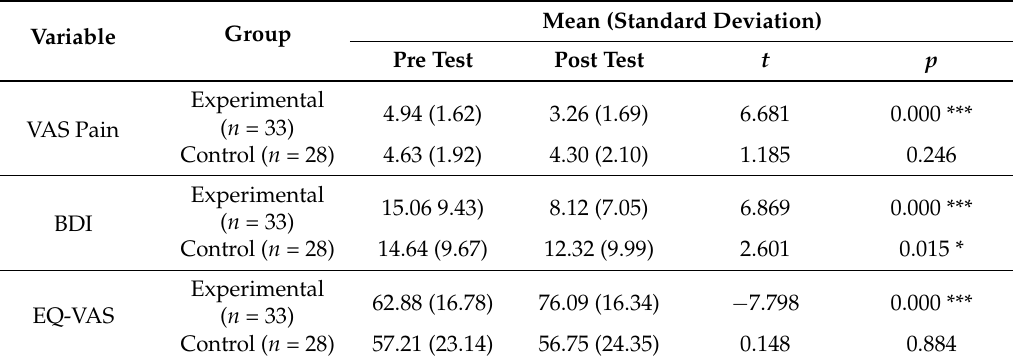
Figure 5. Effect of forest therapy on NK cell activity. Table 4. Comparison of psychological variables pre/post test between experimental and control